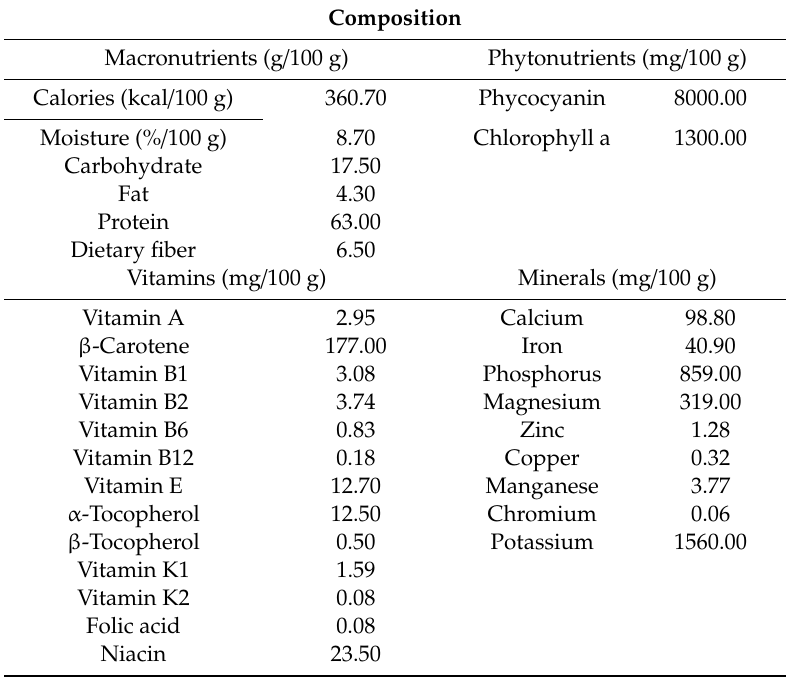
Table 2. Composition of freeze-dried powder of